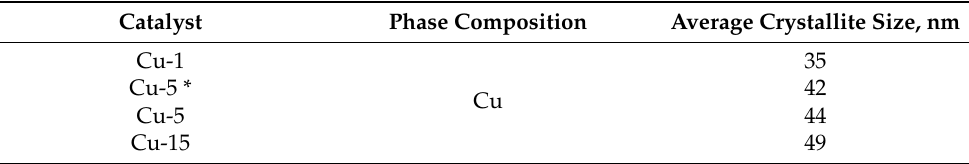
Table 3. Phase composition and average crystallite size of in situ-generated catalysts estimated by